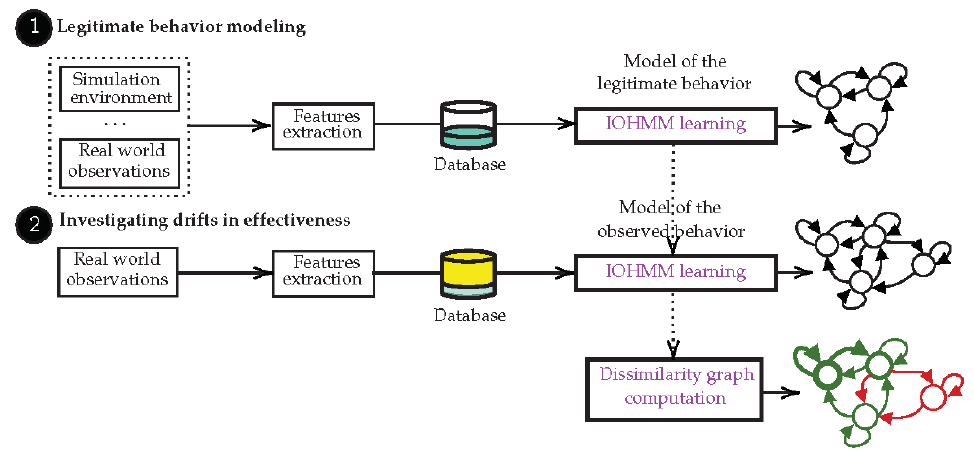
Figure 1. Steps to implement the proposed